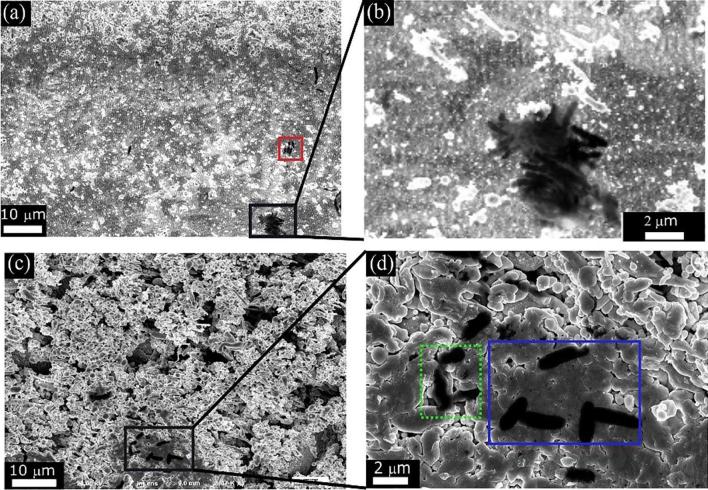
The adhesion of individual bacteria and large bacterial colonies formation on fs-LIPSSs covered with nano/microstructures in (a). (b) The magnified view of bacterial colonies on nanostructure covered fs-LIPSSs. (c) Bacterial colonies are observed for a combination of conic, rods and spherical structures, (d) and a magnified view of the surface clearly showing E. coli bacteria residing in the flat regions of the structured surfaces. In both cases, the colonies are formed within the non-structured regions.